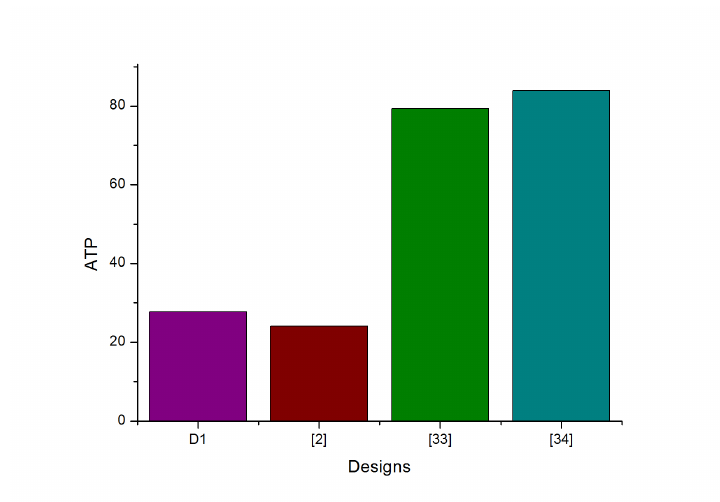
Figure 11. FPGA Implementation ATP.